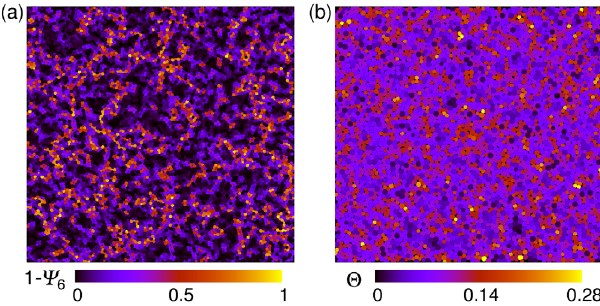
FIG. 8. Spatial distribution of order parameters without coarse graining. (a) Spatial distribution of hexatic order Ψ 6 for an inherent state of 2D polydisperse systems at T ¼ 2 × 10 − 3 , corresponding to Fig. 2(b). (b) Spatial distribution of order parameter Θ for an inherent state of 2D binary systems at T ¼ 1 . 5 × 10 − 3 , corresponding to Fig.